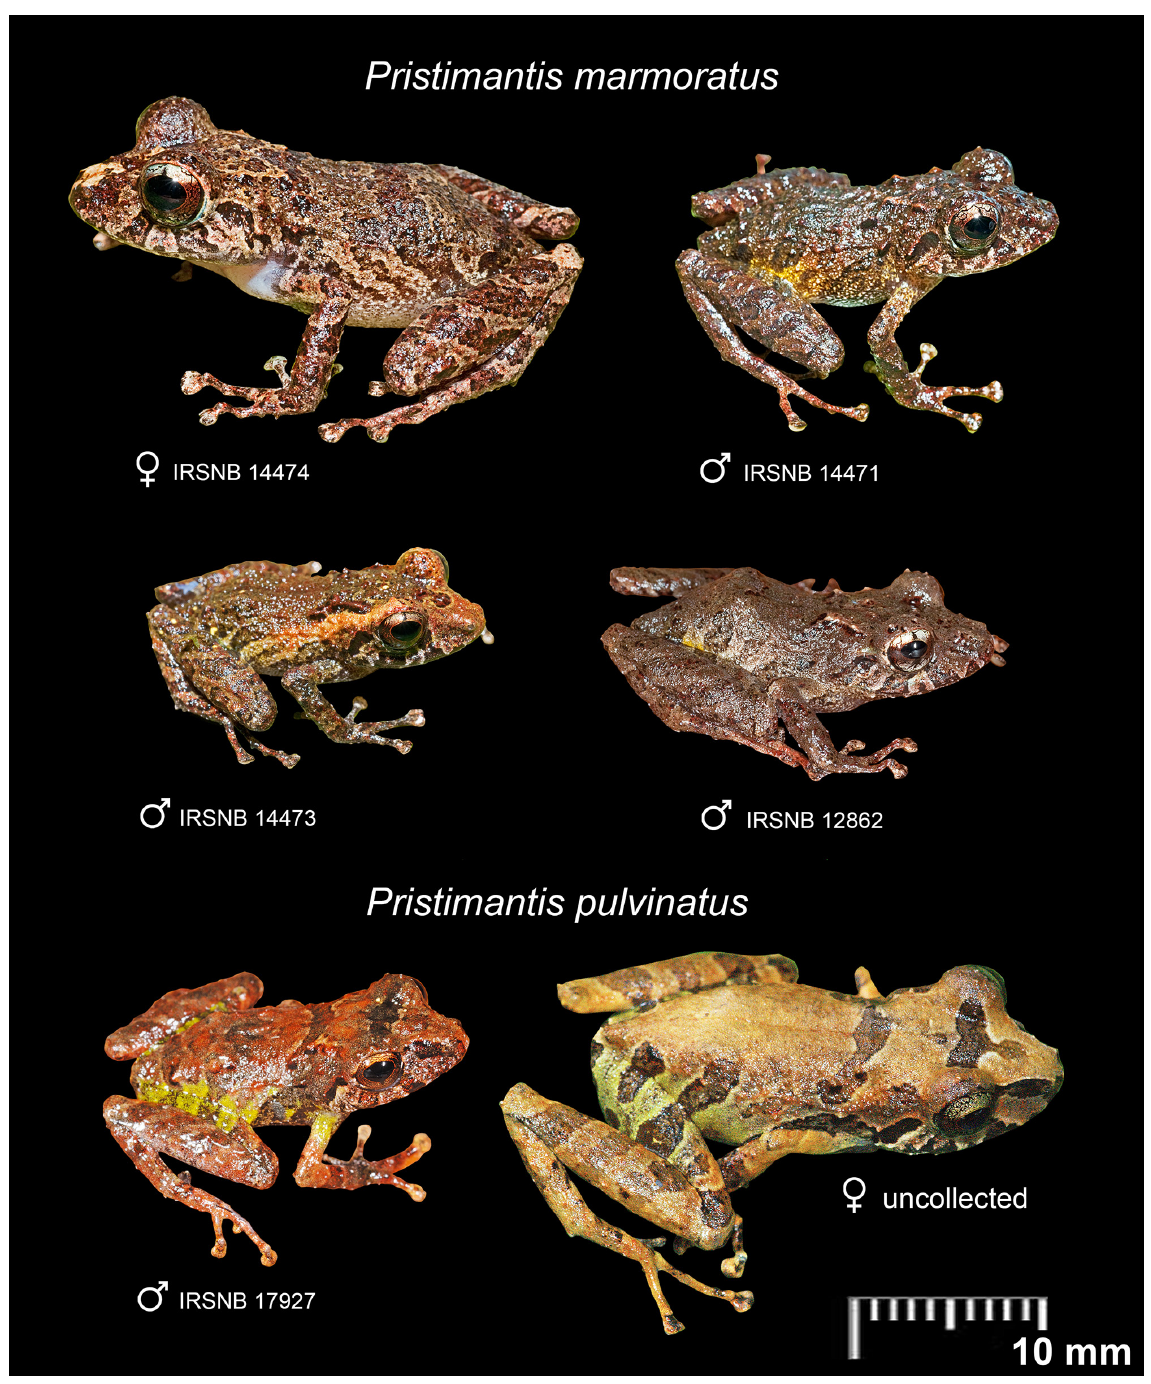
Fig. 4. Pristimantis marmoratus (Boulenger, 1900) (four individuals at the top) and P. pulvinatus (Rivero, 1968) (two individuals below). Intraspecific variation in dorsal colour pattern and sexual dimorphism in living specimens. Note: the subtle hint of green visible on the lower body and legs of some specimens of P. marmoratus is due to a reflection of the substrate (green leaf). Photographs by PJRK, except the uncollected P. pulvinatus , which is